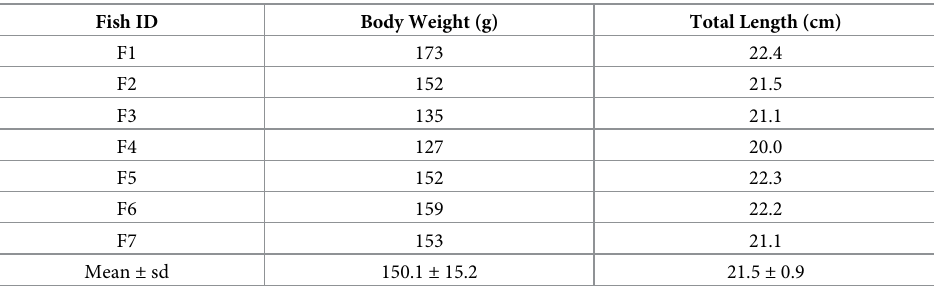
Table 2. Fish information of the seven tagged Siebold’s